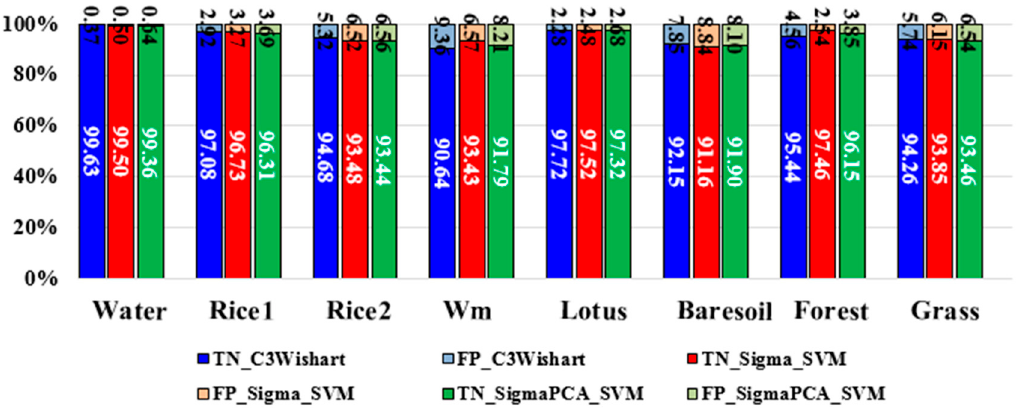
Figure 14. The true negative (TN) rates and the false positive (FP) rates of different polarimetric classification methods. Wm means watermelon.